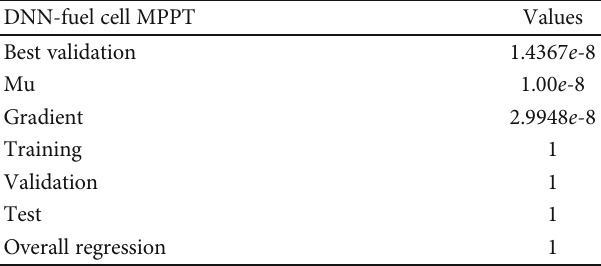
(a) DNN data of the MPPT controller for the FC system